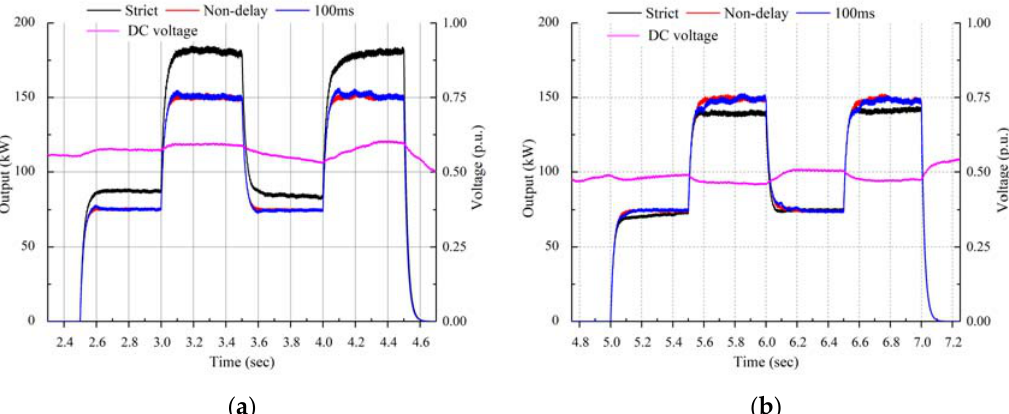
Figure 9. ESS states for multistring topology with 100 ms interval ( a ) extracted power quantity in the discharging section (2.5 to 4.5 s); ( b ) absorbed power quantity in the charging section (5 to 7 s).